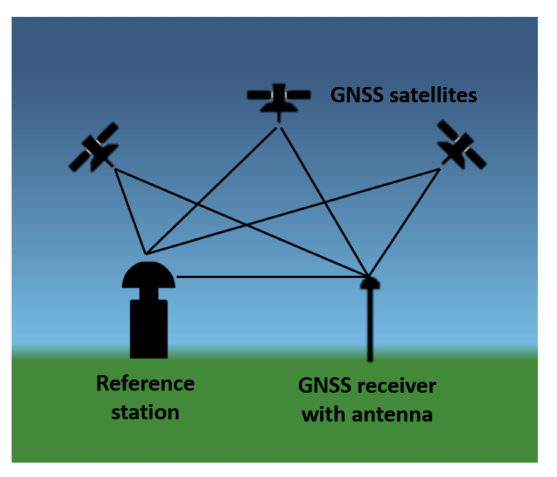
Figure 2. Scheme of Global Navigation Satellite Systems (GNSS) measurement using the di ff erential